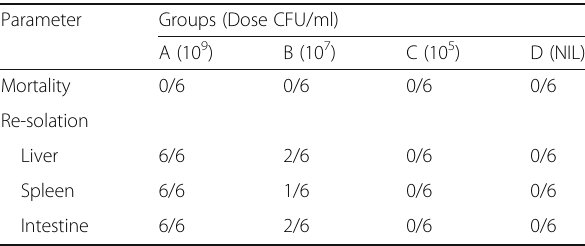
establishment of infection, survival and re-isolation frequency